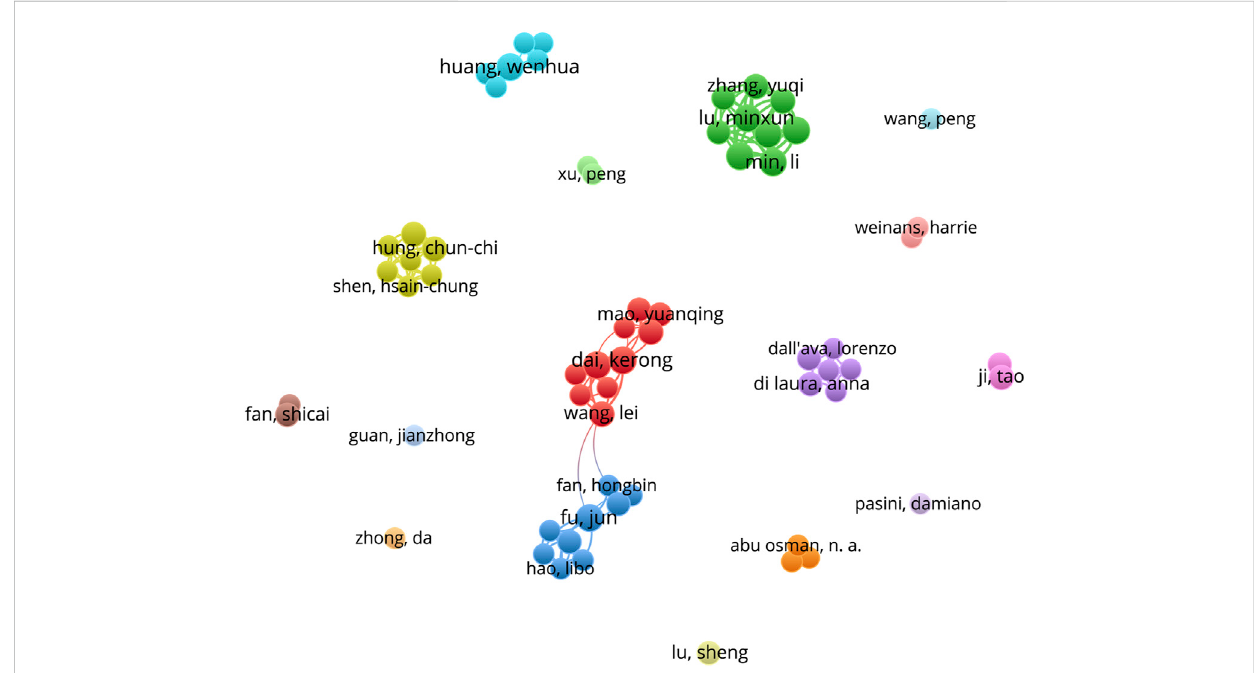
FIGURE 5 Cooperation network of productive authors. (The map ’ s bubbles represent authors, and the lines connecting the bubbles represent collaborative relationships. The larger the bubble area, the greater the number of publications.).